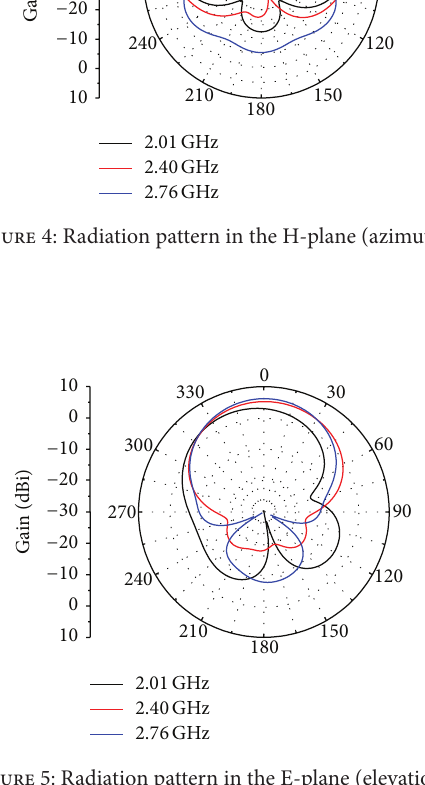
Figure 5: Radiation pattern in the E-plane